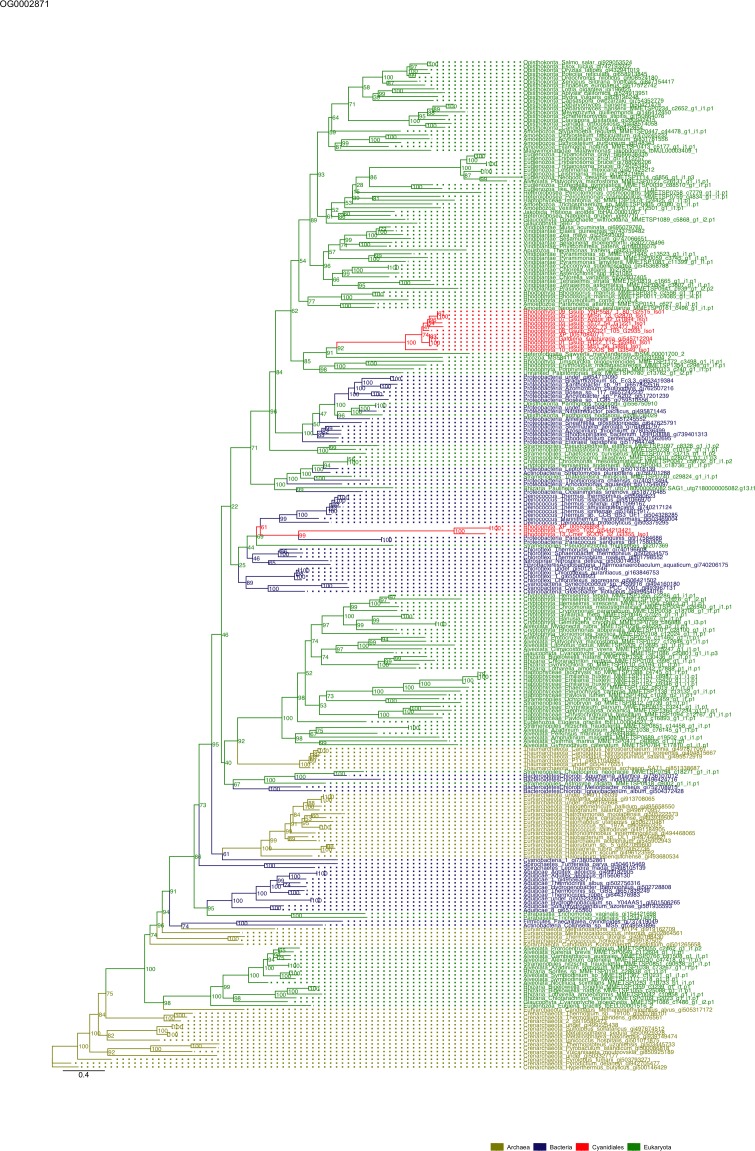
Sequence tree of orthogroup OG0002871.The tree is based on amino acid sequences. Archaea (yellow), Bacteria (blue), Cyanidiales (red), Eukaryotes including other red algae (green). Branches containing Cyanidiales sequences are highlited in red.